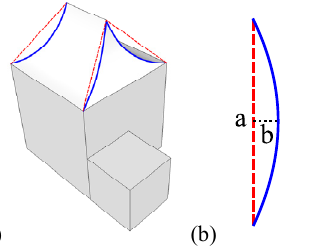
Figure 10. Close-range photograph of a building (a) and vanishing points (b).